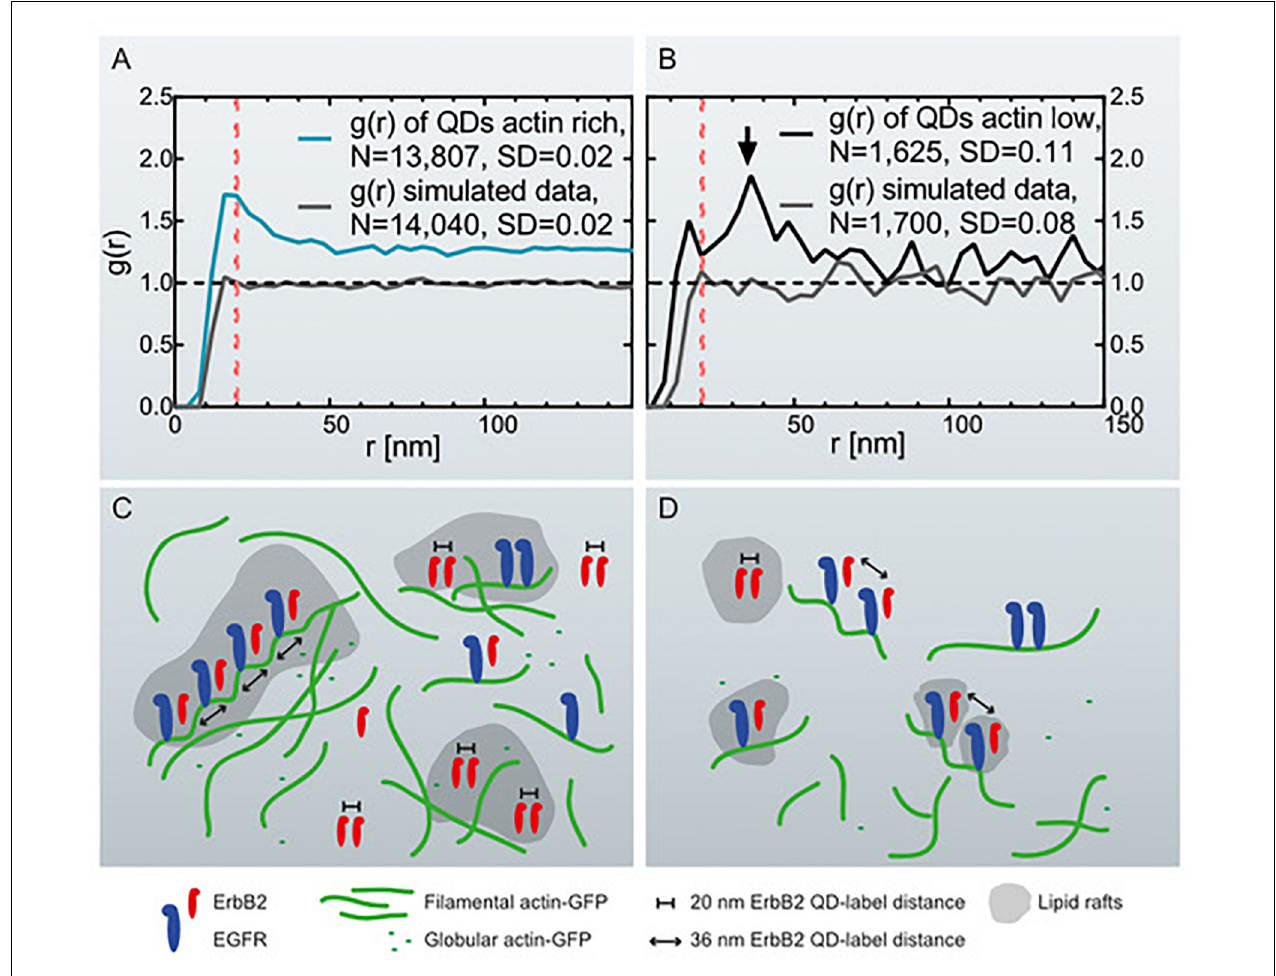
FIGURE 3 | Graphs of the pair correlation function g ( r ) versus the radial distance r between QD-labels, collected at actin-rich- and actin-low cell regions with correlating schemes. (A) g ( r ) of QD-labels detected in actin-rich cellular regions collected from 27 images of 11 cells. The red dotted line marks g ( r ) = 20 nm. As comparison, g ( r ) of simulated data is included of randomly positioned labels with the same particle density (see Table 1 ). (B) g ( r ) of QD-labels in actin-low regions collected in 17 images of 8 cells. The arrow marks a peak at r = 36 nm. The red dotted line is at r = 20 nm. g ( r ) of simulated data of randomly positioned labels is also included. (C) Schematic representation of the assumed distribution of ErbB2 and EGFR homo- and heterodimers in relation to cortical actin filaments and lipid rafts in actin-rich, ruffled cell regions. EGFR is bound to actin filaments while ErbB2 can move freely in the membrane and lipid rafts. Those ErbB2 molecules assembled in ErbB2:EGFR heterodimers are bound to helical actin filaments with a pitch of 36 nm. The number of ErbB2 homodimers in ruffled regions outweighs the number of postulated heterodimers. (D) Actin-low, flat cell regions with fewer ErbB2 homodimers being present than in ruffled regions, and postulated heterodimers dominating the analysis. The ruffled regions contain a higher number of growth factor receptors than the flat regions.